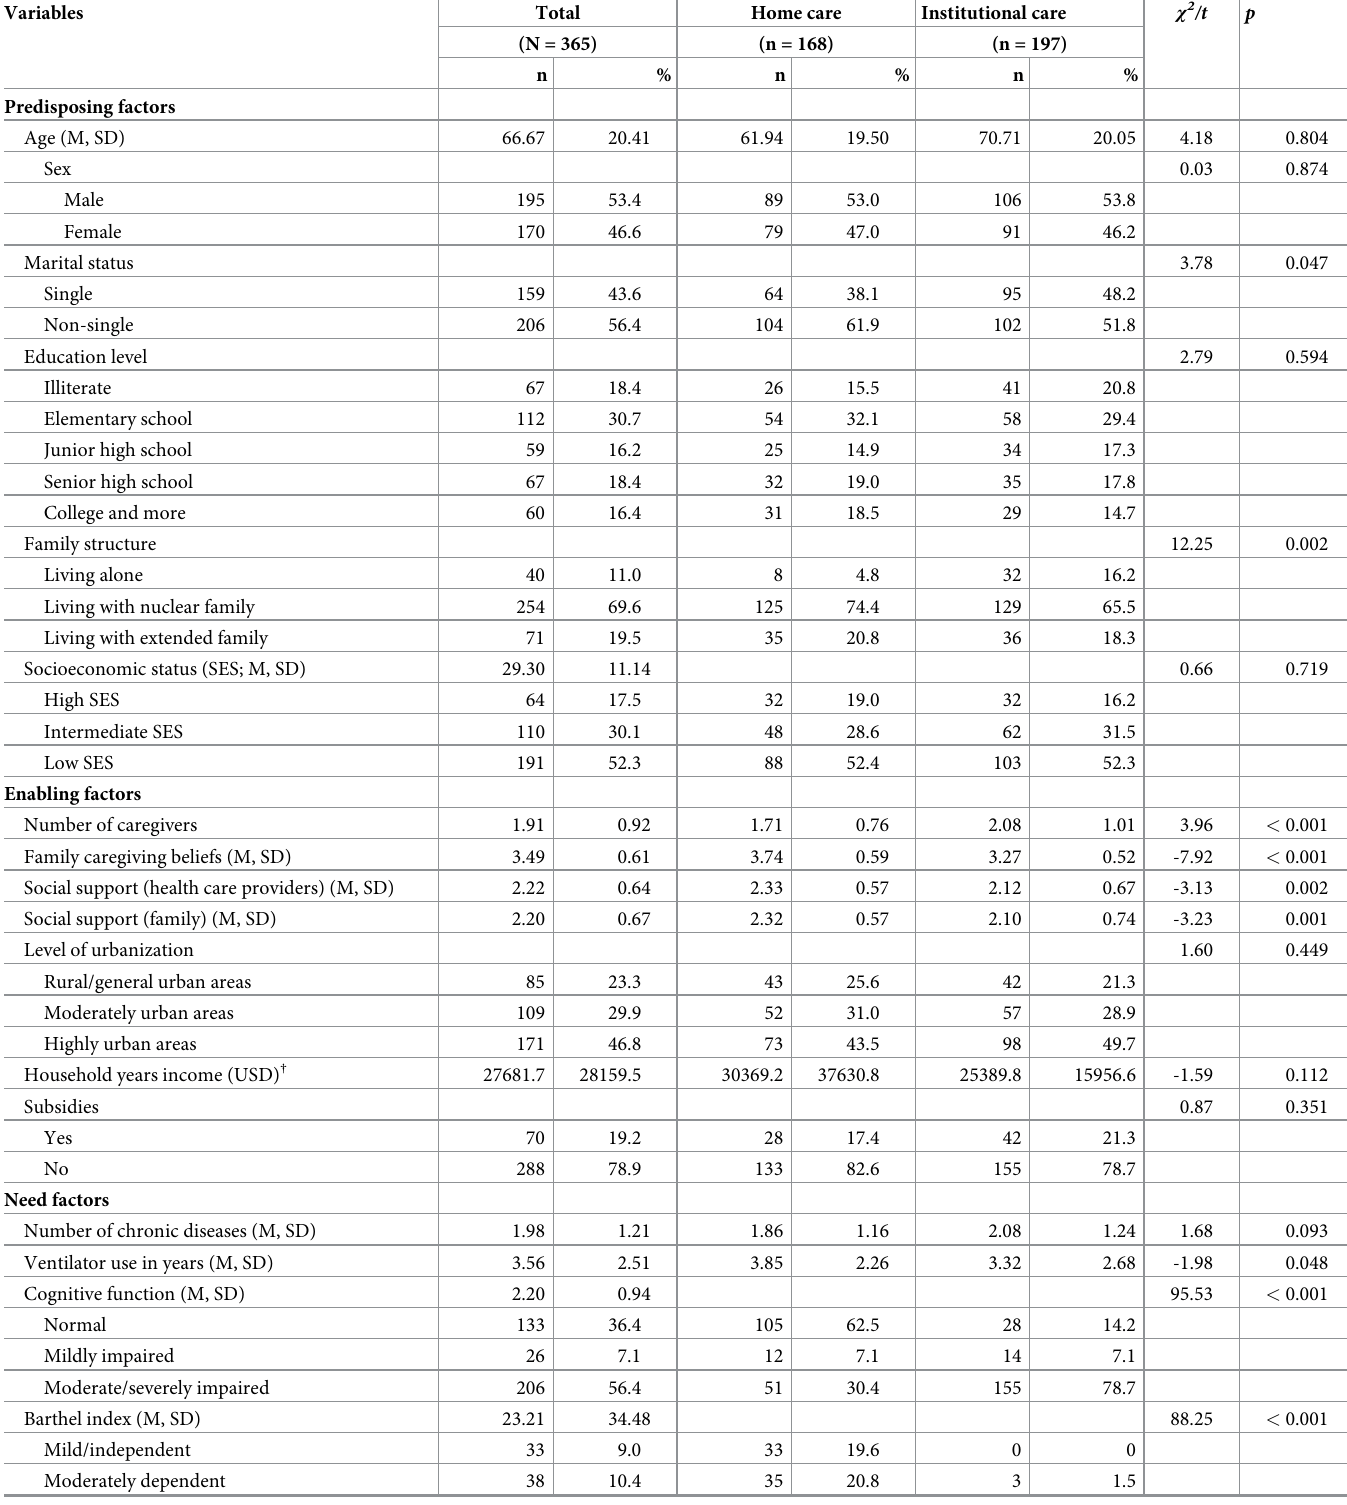
Table 1. Characteristics of long-term mechanical ventilation patients (N =